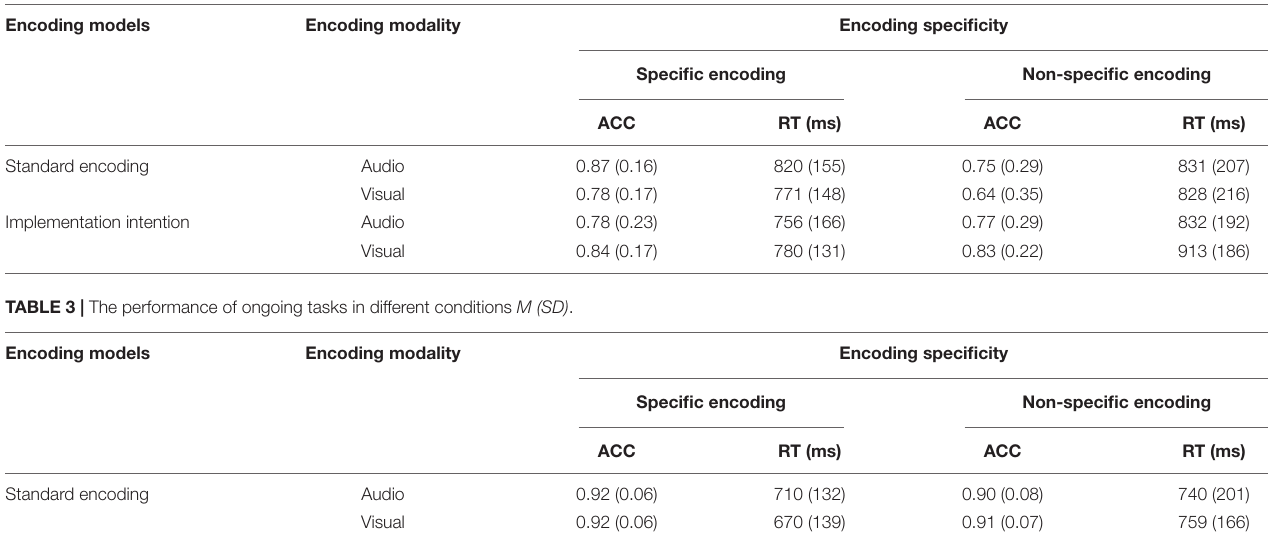
TABLE 2 | The performance of ProM tasks in different conditions M (SD) .